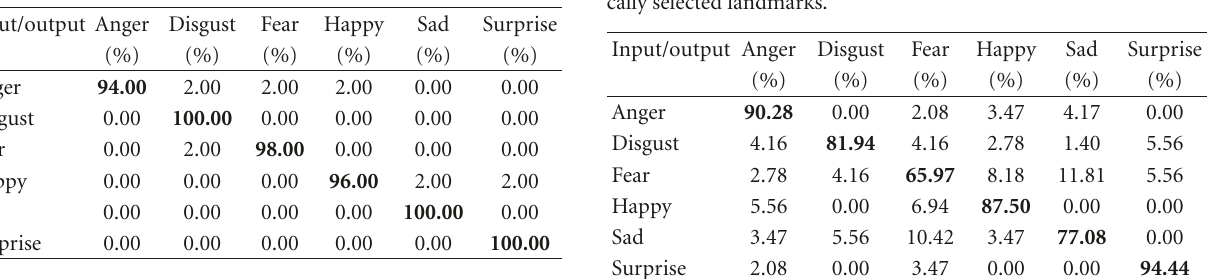
Figure 11: Quantitative evaluation of facial expression separability in the SSV feature spaces. Table 2: Confusion matrix of the LDA classifier for the synthetic faces.